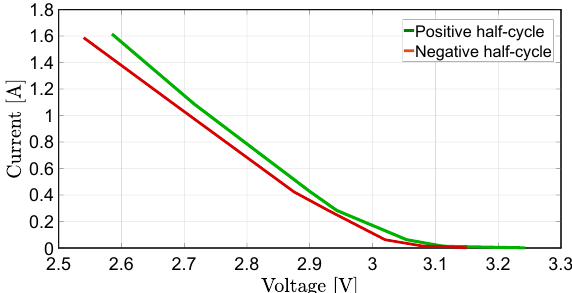
Figure 11. Voltage vs balancing current (experimental